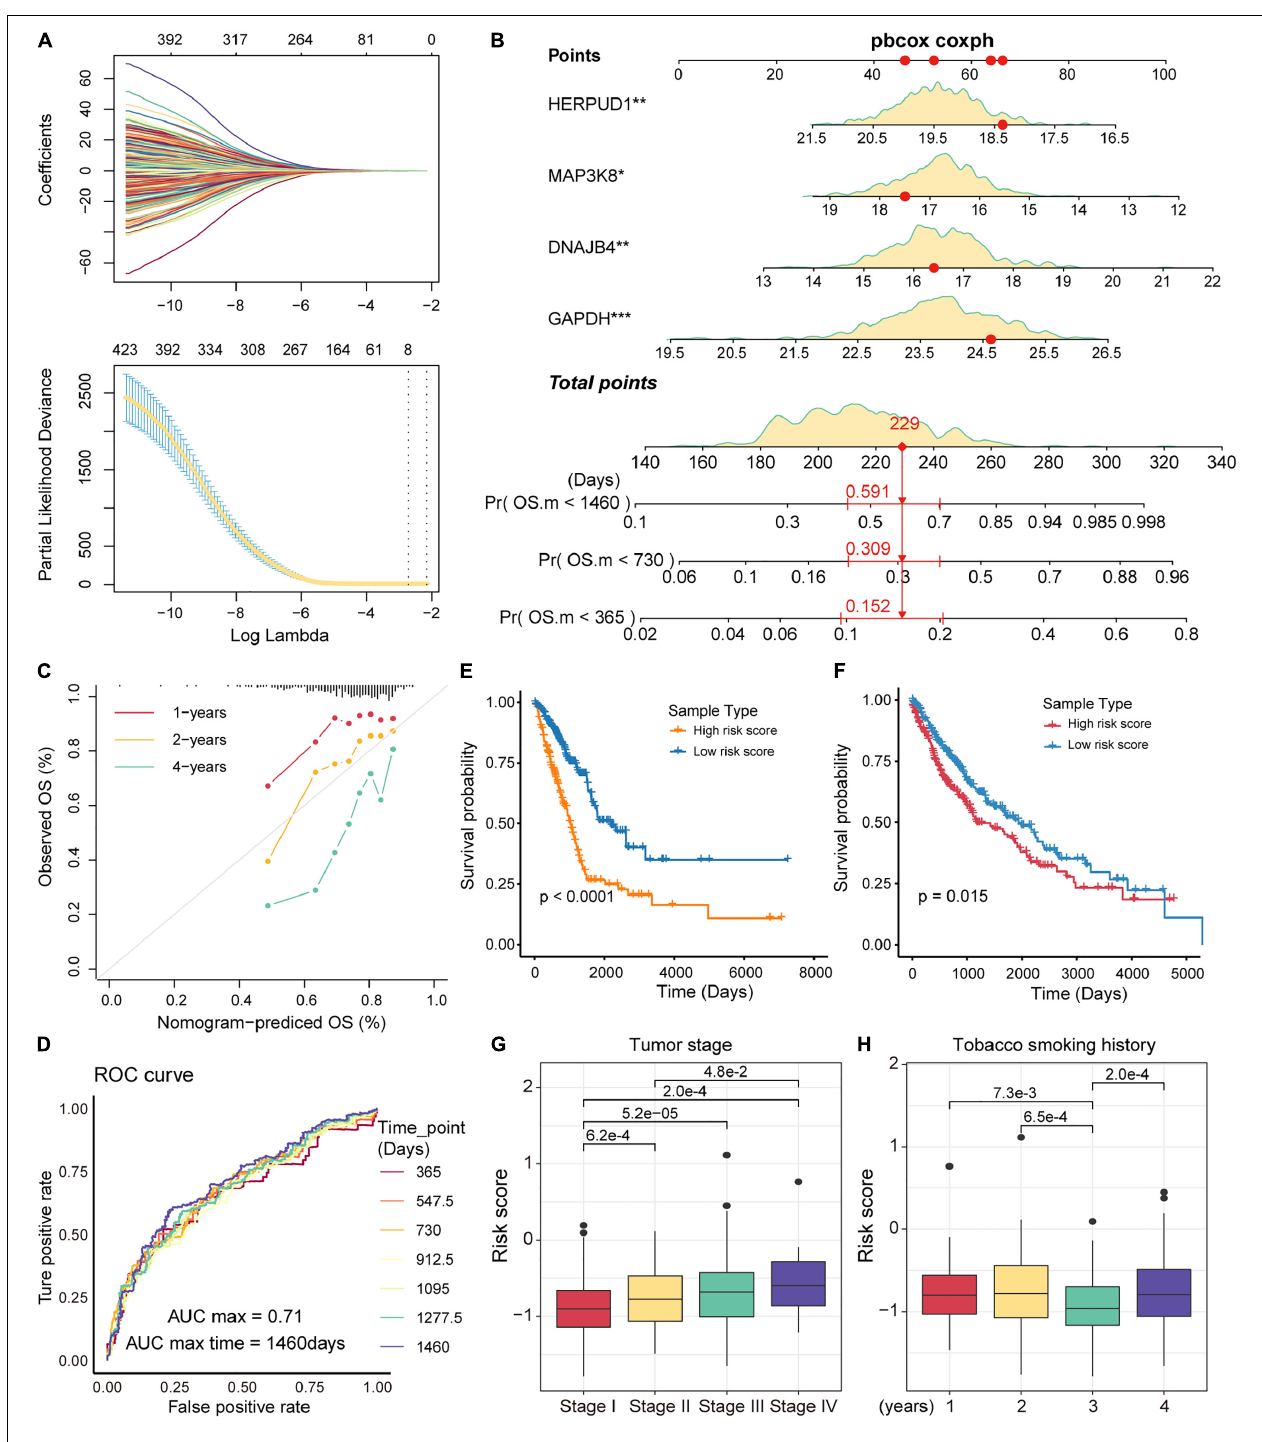
FIGURE 5 | Identification of prognostic markers in non-small cell lung cancer (NSCLC). (A) The curves reflect the relationship between the regression coefficient and λ value. The features were selected by the lasso regression model. (B) Nomogram for survival risk prediction of 1, 2, and 4 years. The model contains four feature genes (prognostic markers). (C) Calibration curve of the nomogram. (D) Receiver operating characteristic (ROC) plots of the outcomes predicted by the risk regression model for seven time points. The different colored curves represent specific time points. (E) Kaplan-Meier (KM) curves for the survival time (days) of lung adenocarcinoma (LUAD) samples in high- and low-risk categories. The log-rank test was used to calculate statistical significance. (F) Same as in (E) but for the survival of lung squamous cell carcinoma (LUSC) samples. (G) Box plots of risk scores for different tumor stage samples. The rank-sum test was used to statistically measure differences between groups. (H) Same as in (G) but for samples with different smoking histories.